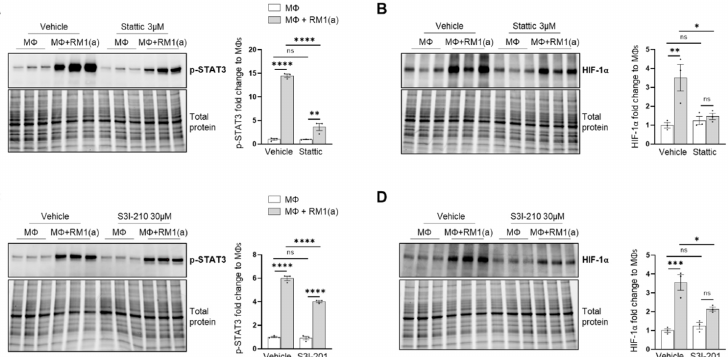
Figure A1. p-STAT3 inhibition in C57BL/6J in BM macrophage efferocytosis of apoptotic prostate cancer RM1 cells. BM macrophages (M Φ ) were isolated from 4 wk old C57BL/6J mice and co-cultured with apoptotic RM1(a) cells for 16–18 h ( n = 3). ( A , B ) Western blot of protein lysates from efferocytic and control BM macrophages treated with 3µM Stattic (p-STAT3 inhibitor) using p-STAT3 and HIF-1 α antibodies. ( C , D ) Western blot of protein lysates from efferocytic and control BM macrophages treated with 30 µM S3I-210 (p-STAT3 inhibitor) using p-STAT3 and HIF-1 α antibodies. Plotted data are shown as mean ± SEM, * p < 0.05, ** p < 0.01, *** p < 0.001, **** p < 0.0001, ns = not significant (ordinary one-way ANOVA; Tukey’s multiple comparison test).